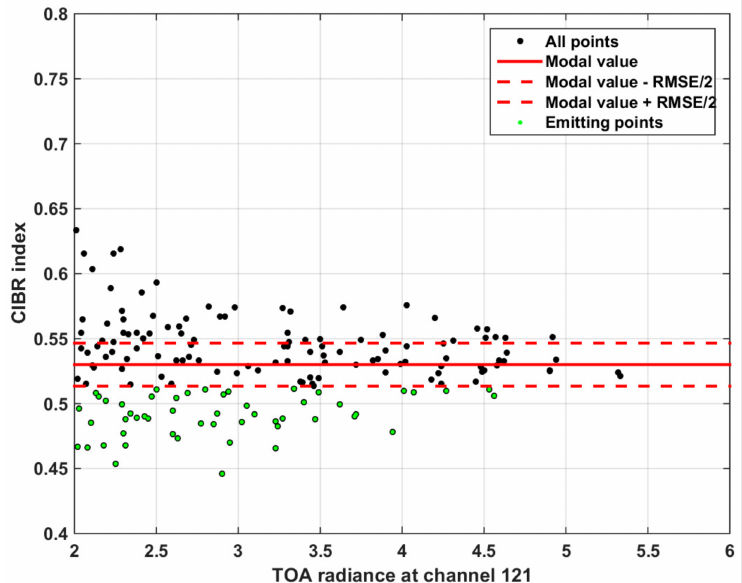
Figure 10. Distribution of CIBR values for TOA 121 greater than 2 Wm − 2 sr − 1 µ m − 1 (Solfatara case